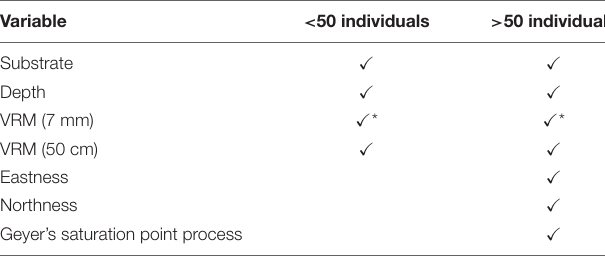
TABLE 3 | The variables considered in the PPM